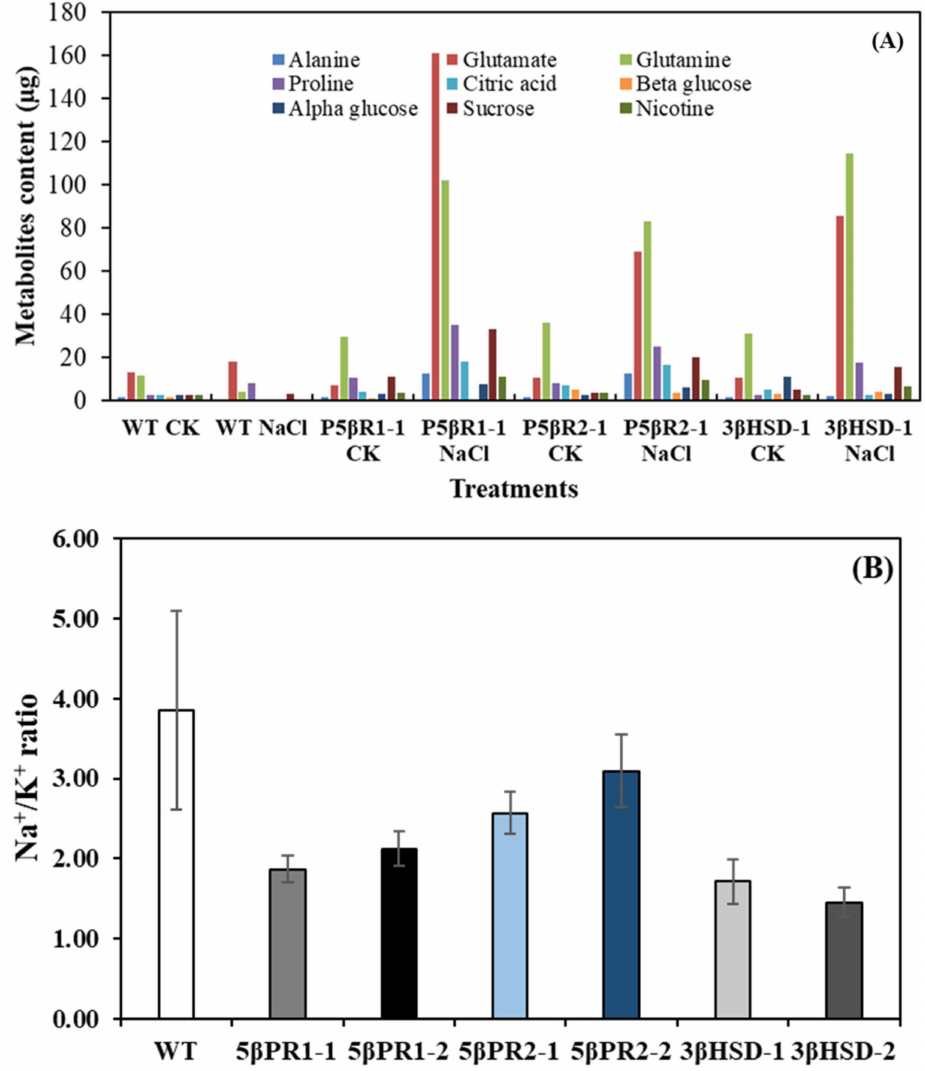
Figure 6. NMR-based metabolites in WT and transplastomic (P5 β R1, P5 β R2, 3 β -HSD) lines in control (CK) and under salt stress (300 mM NaCl). ( A ) The three seedlings of each line or WT were used for the metabolites analysis. ( B ) The Na + /K + ratio in WT and the independently generated transplastomic lines of the 3 β -HSD , P5 β R1 and P5 β R2 genes (P5 β R1-1, P5 β R1-2, P5 β R2-1, P5 β R2-2, 3 β -HSD-1 and 3 β -HSD-2) grown under NaCl (300 mM) stress. Data shows average of three repeats and error bars represent ±